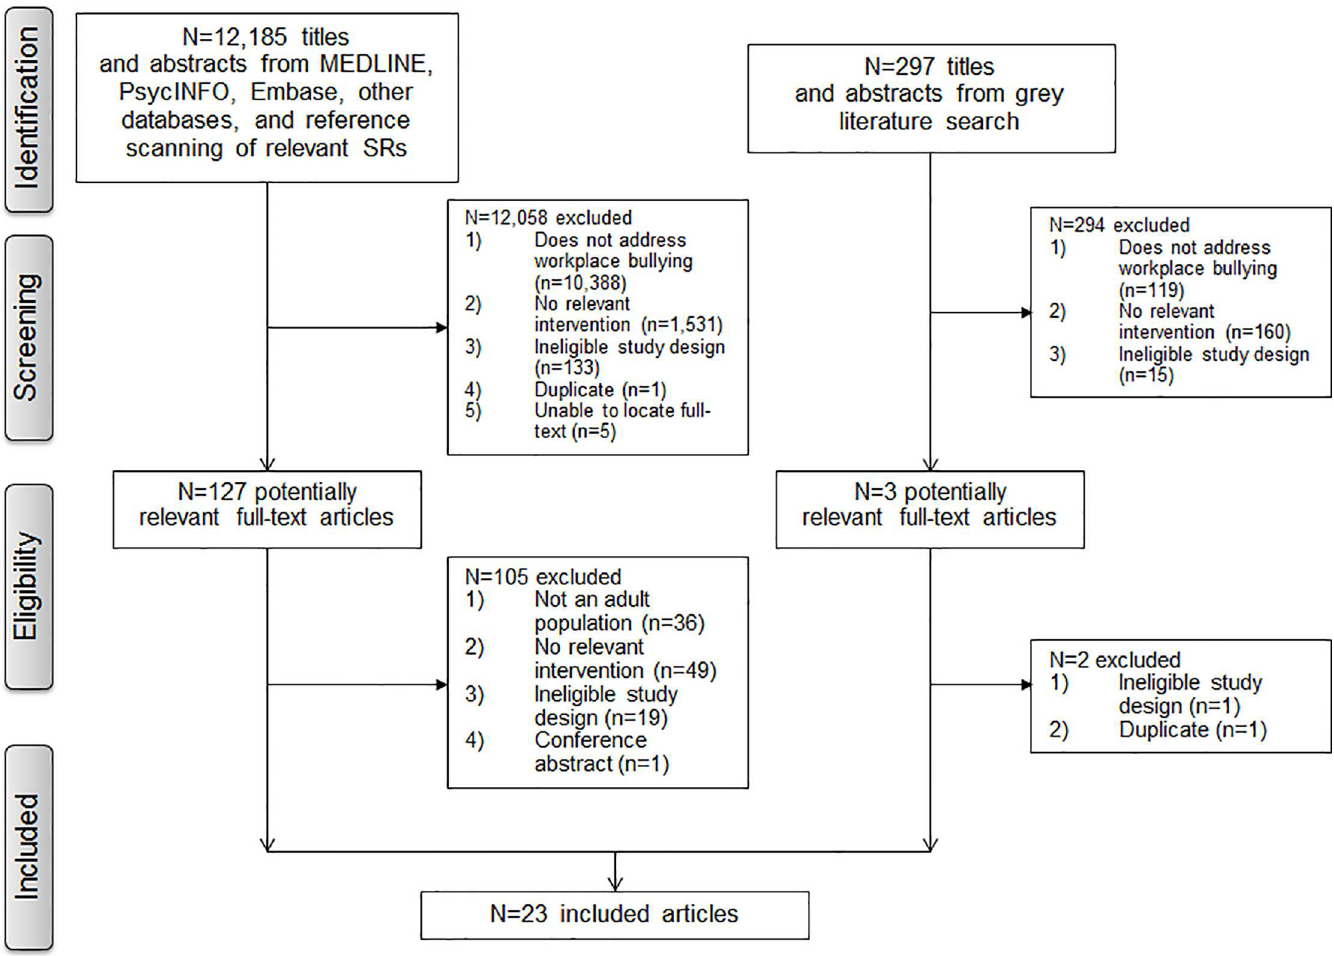
Fig 1. Study flow